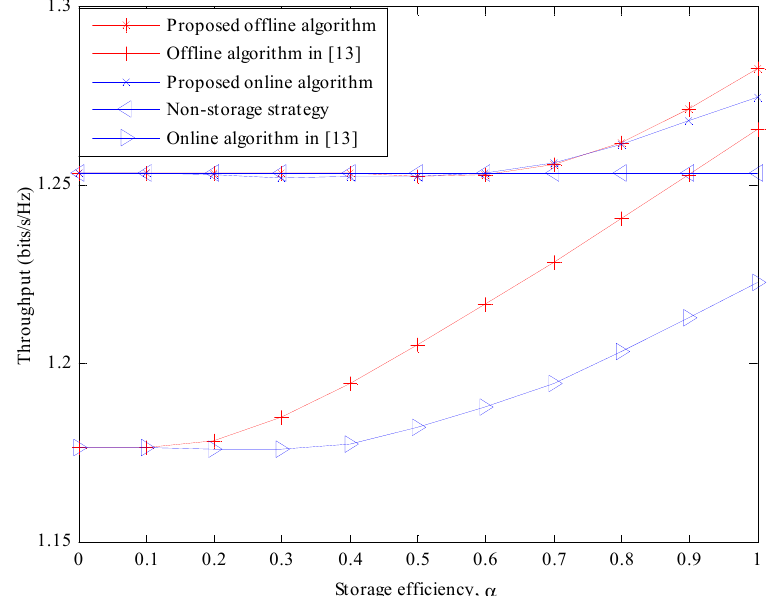
Figure 2. Throughput for the time-invariant channel with energy arrivals obeying the uniform distribution of [5, 15] mJ.